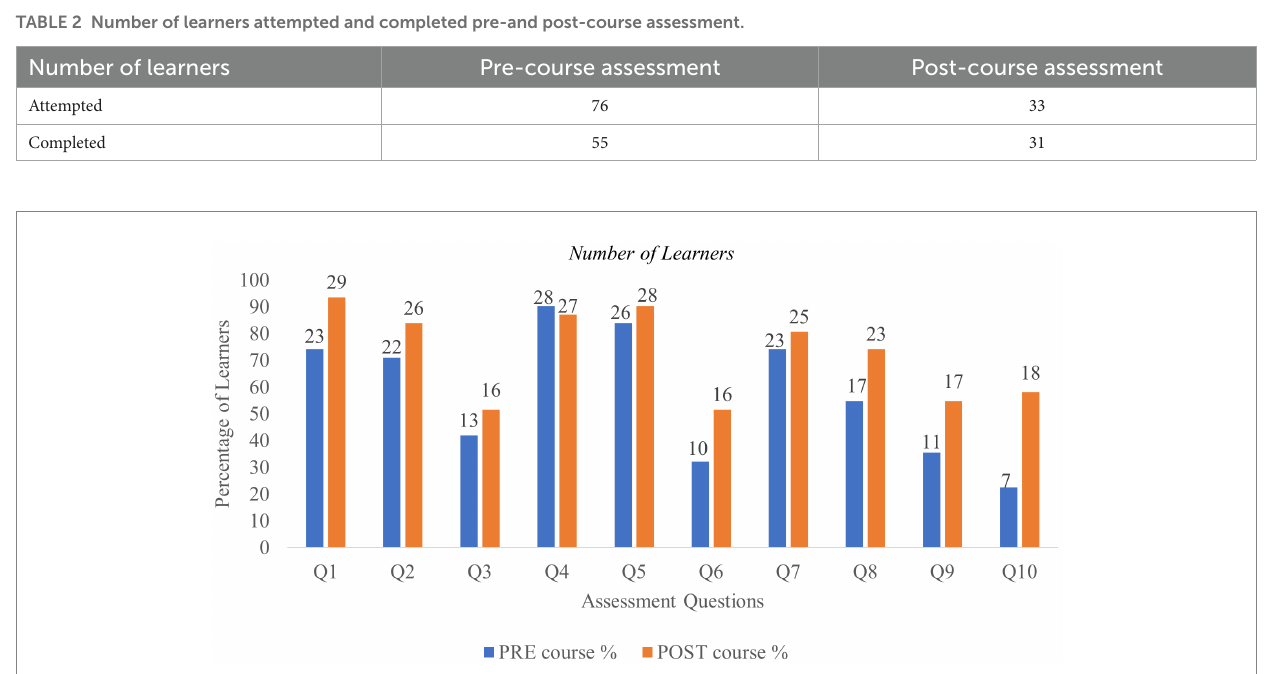
FIGURE 1 Correct responses (%) for individual questions in the pre- and post-course assessment.